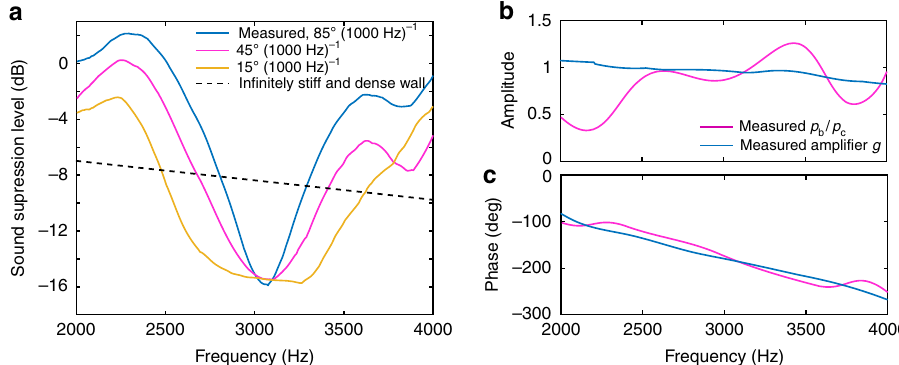
Fig. 4 Measured sound suppression level. a Measured suppression level compared against the suppression levels expected for ampli fi ers having impulse response phase gradients of 45°(1000Hz) − 1 and 15°(1000Hz) − 1 . b Amplitude and c phase of metasurface bianisotropic relative response p b / p c measured at point A in Fig. 2a and compared against measured ampli fi er impulse response